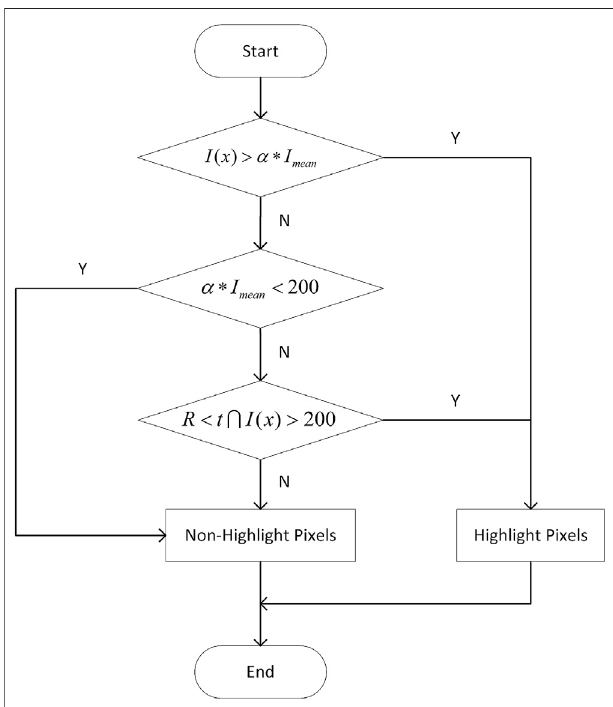
FIGURE 1 | Overall fl owchart of the proposed highlight detection